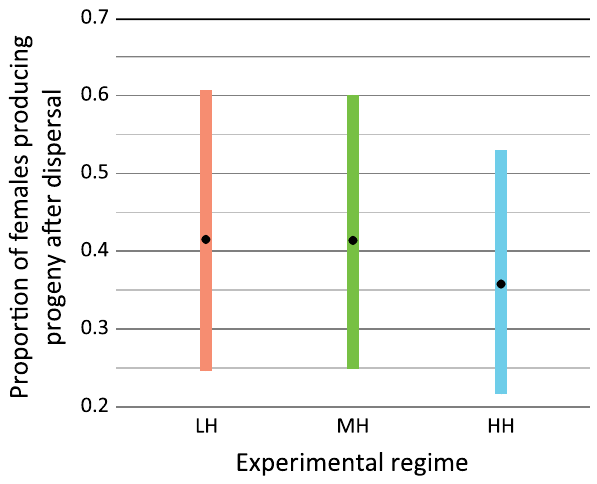
Figure 4. Proportion of females reproducing after dispersal to all dispersing females. Dots represent means and bars denote 95% CI.